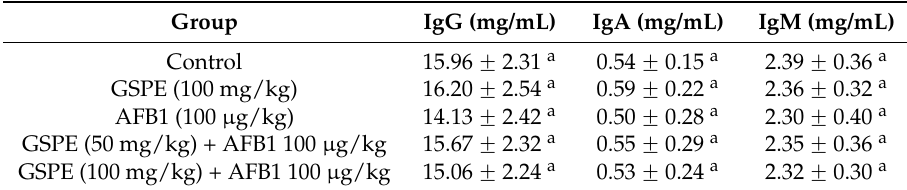
Table 1. Effect of GSPE on immunoglobulin levels in mice induced by AFB1.